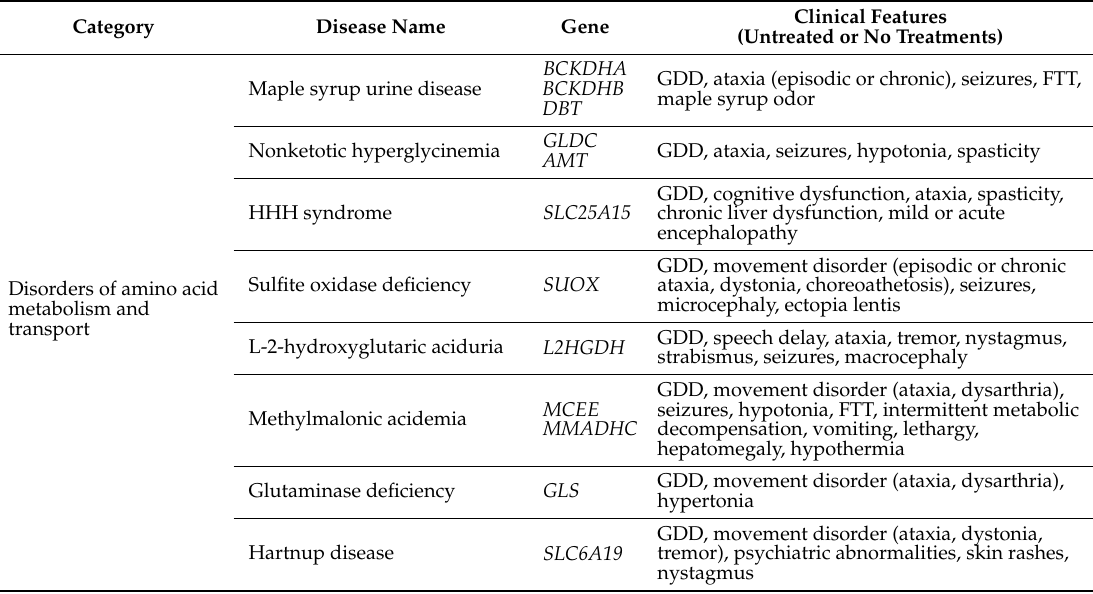
Table 1. Inherited metabolic disorders presenting with ataxia are summarized by disease category, genetic defect, and clinical